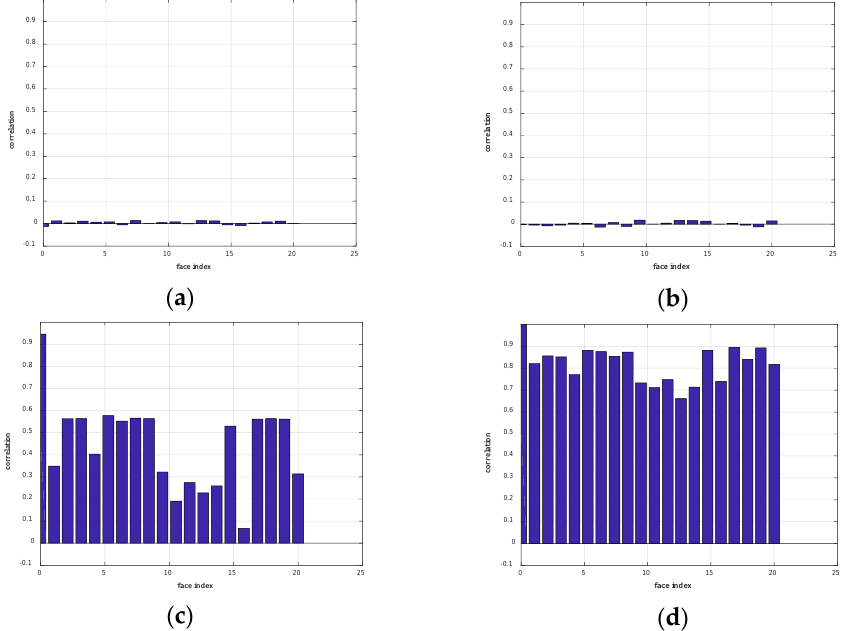
Figure 10. Correlation scores for unauthorised imposter patterns (for ORL dataset) for ( a ) CFR1, ( b ) CFR2, ( c ) homomorphic transform followed by salting and ( d ) homomorphic transform followed by random kernel convolution.